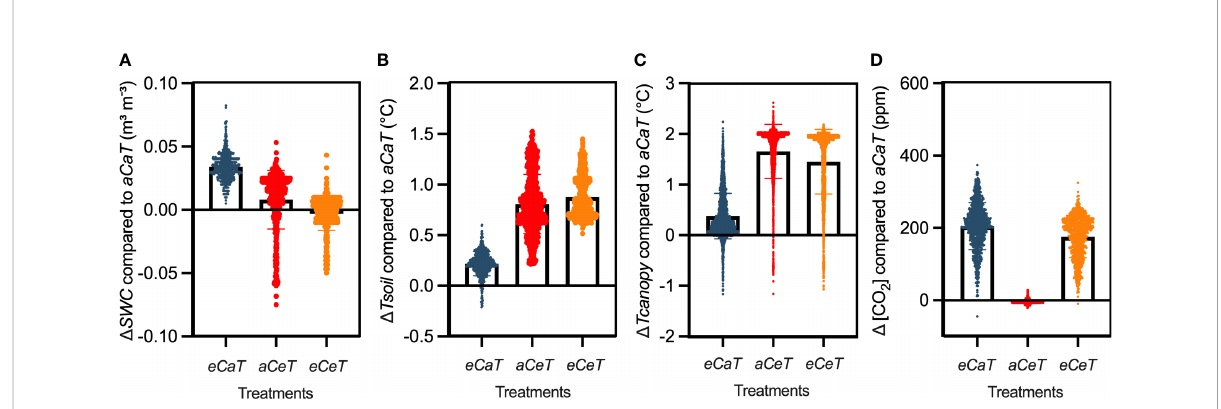
FIGURE 1 Difference ( D ) in the microclimate of each treatment compared to ambient conditions ( aCaT ). (A) SWC = soil water content (m 3 m -3 ), (B) Tsoil = soil temperature (°C). (C) Tcanopy = canopy temperature (°C). (D) [CO 2 ] = atmospheric CO 2 concentration. Bars show the average difference between treatments and aCaT , whilst each point shows the dispersion around the average value. Points were obtained each hour for SWC and Tsoil and every 15 minutes for Tcanopy throughout the entire experiment. For [CO 2 ], each point represents a 5-minute average value along six days of the experimental period during the diurnal period (6 am to 6 pm - fumigation period). Treatments: aC (ambient CO 2 concentration), eC (elevated CO 2 concentration – 600 ppm), aT (ambient temperature), and eT (elevated temperature - 2°C above ambient